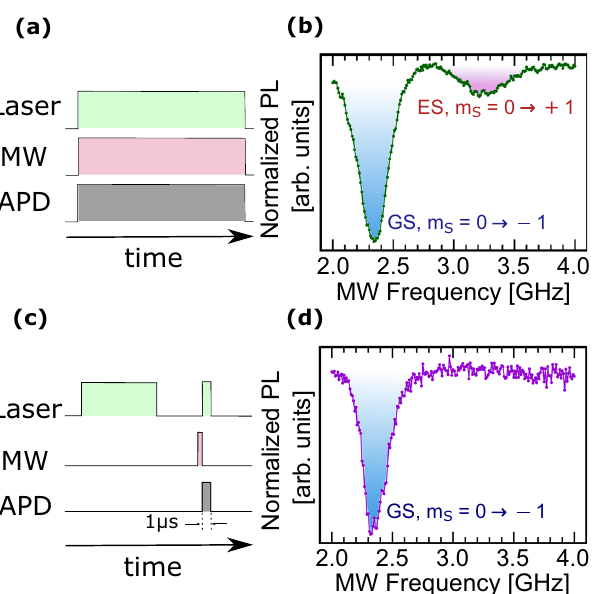
Fig. 3 Pulsed ODMR at B 0 = 400 G. a CW ODMR is performed with the pumping laser, B MW , and avalanche photodiode (APD) photon counters on at all times. b The resulting CW ODMR spectrum shows spin transitions in both the GS (blue) and ES (red). c Pulsed ODMR is performed with B MW on only when the laser is off, after the defect is initialized to m S ¼ 0 GS. As soon as B MW is turned off, the laser and photon counters are then turned on to read out the spin state. d The resulting pulsed ODMR spectrum indicates spin rotation only in the GS, con fi rming that the additional broader resonance is from an ES transition.